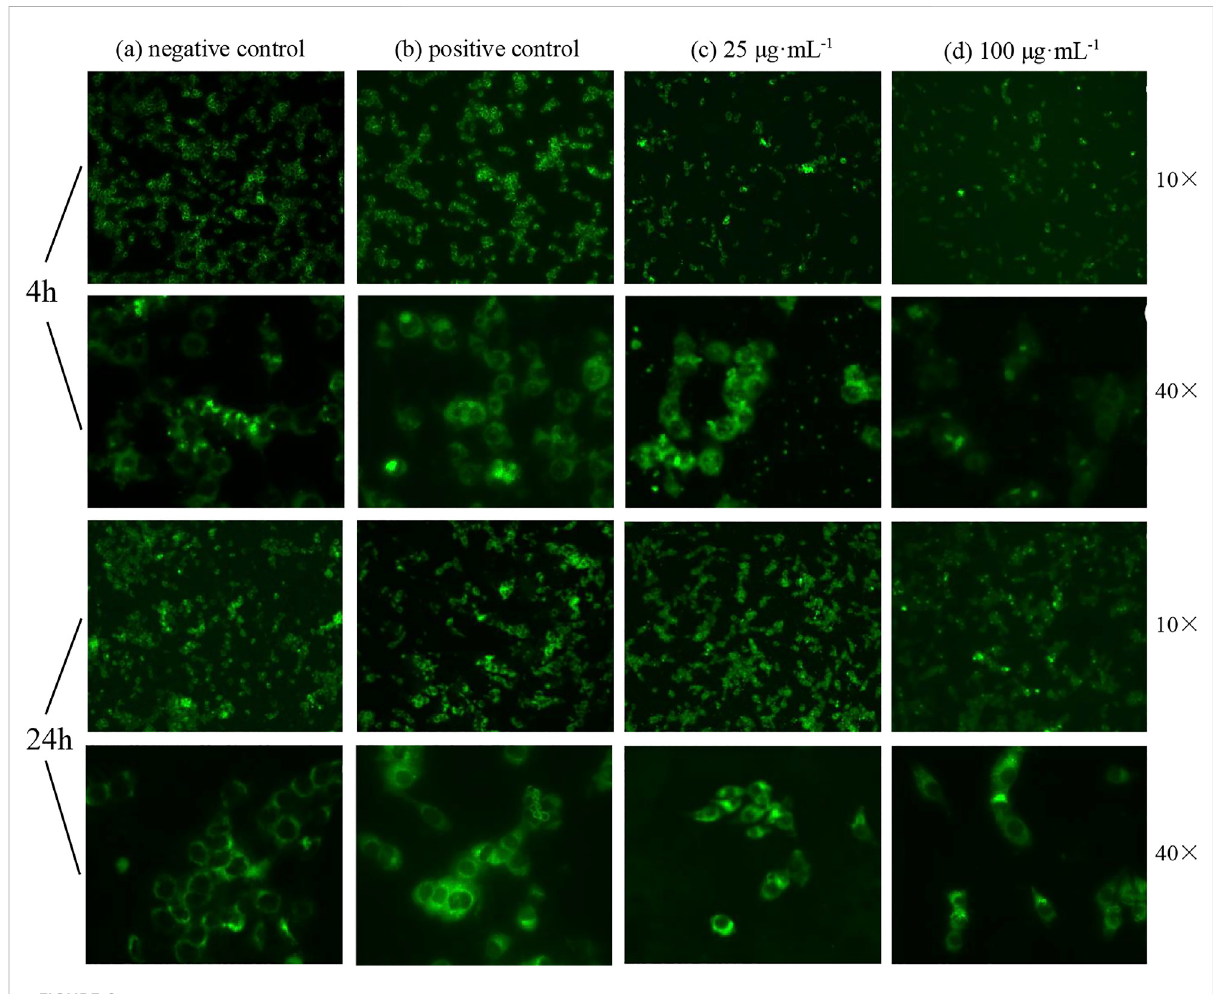
FIGURE 8 Fluorescence changes of cells treated with ZnO nanosheets for different hours (using ×10 or ×40 inverted fl uorescence microscopes). (A) Negativecontrol; (B) positivecontrol; (C) concentrationof25 μ g ml − 1 ; (D) concentrationof100 μ g ml − 1 .Asshowninthe fi gure,theintracellularROS level increased signi fi cantly with the increase in nanomaterial action time on cells; different degrees of welling or deformation were observed in some cells under high magni fi cation, and green fl uorescence showed uneven and irregular cell